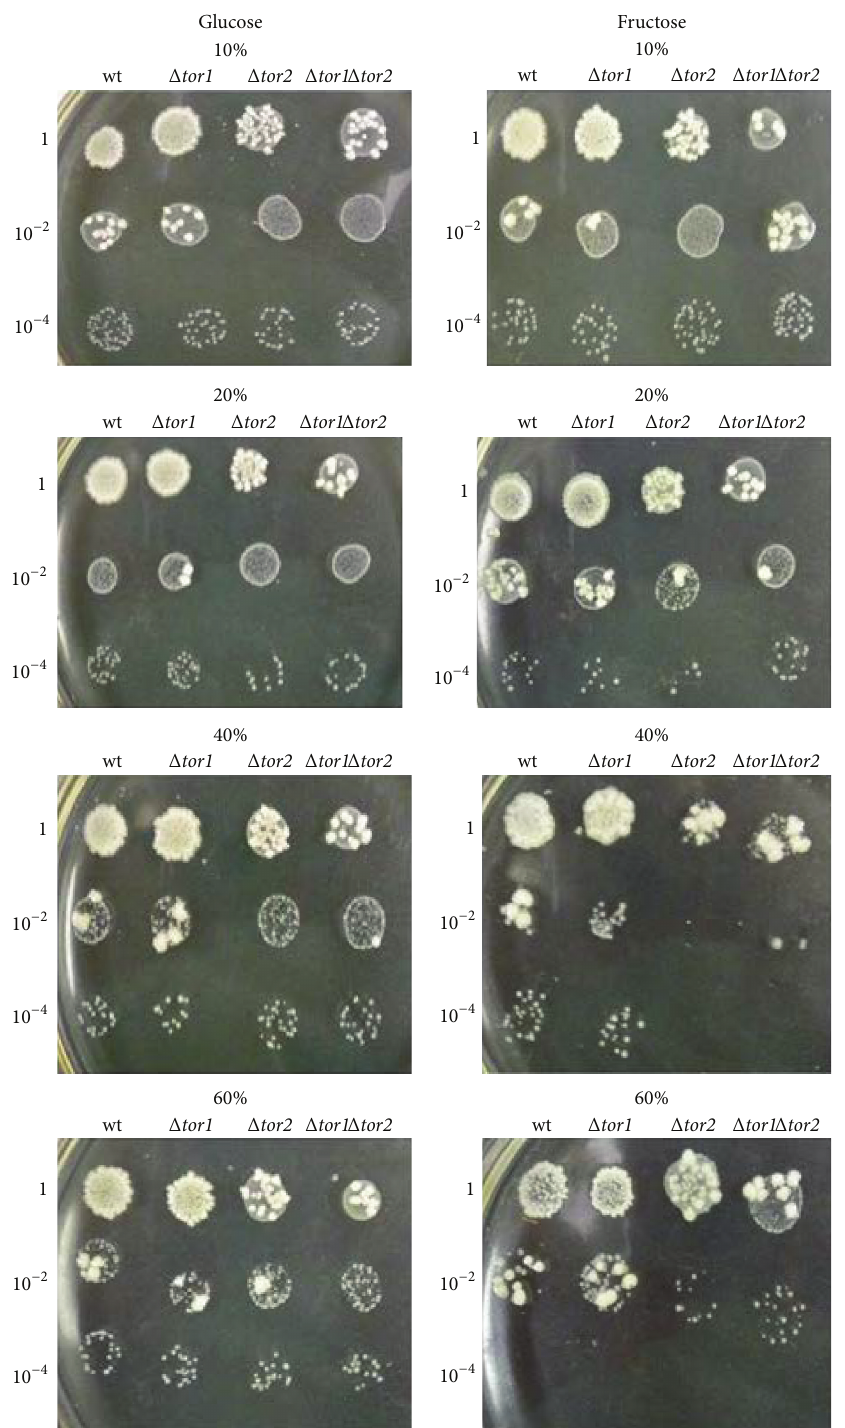
Figure 7: Cell viability assay of S. cerevisiae JK9-3da (wild type), Δ tor1 , Δ tor2 , and Δ tor1 Δ tor2 cells after exposure to high concentrations of glucose and fructose. In all samples within each plate, cell concentration was equaled and successively diluted by a factor of 100 down to 10 −4 . Representative results from a set of three experiments are